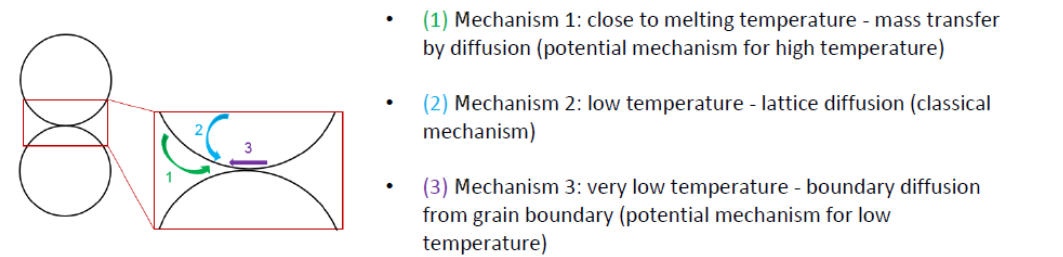
Figure 2. Different sintering mechanisms of snow for different temperatures proposed by analogy with the hot ceramic sintering (inspired by Fig. 1 in Ashby, 1974). Note that more sintering mechanisms can be found in the literature: in their initial figure, Ashby (1974) mentioned six different mechanisms but only two permit densification (lattice diffusion and boundary diffusion from grain boundary). The attributions of three different mechanisms for the firn densification model based on the powder aggregate study from Ashby (1974) is only a working hypothesis